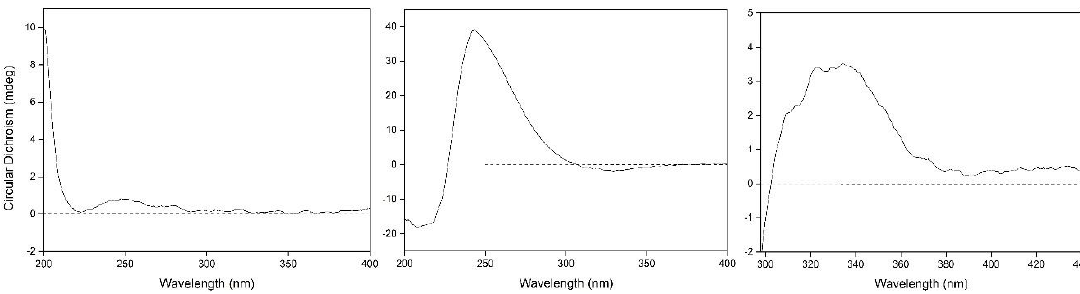
Figure 4. Circular dichroism (CD) spectra of compounds 1 (left) and 11 (middle) and induced circular dichroism (ICD) spectrum of 11 (right).